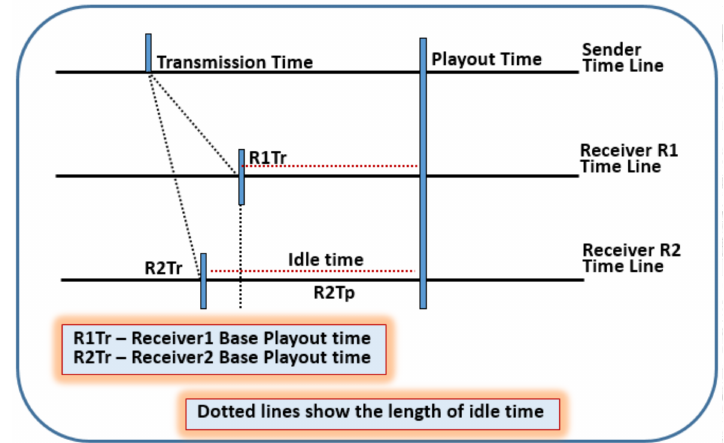
Figure 6. Timeline diagram shows the effect of our